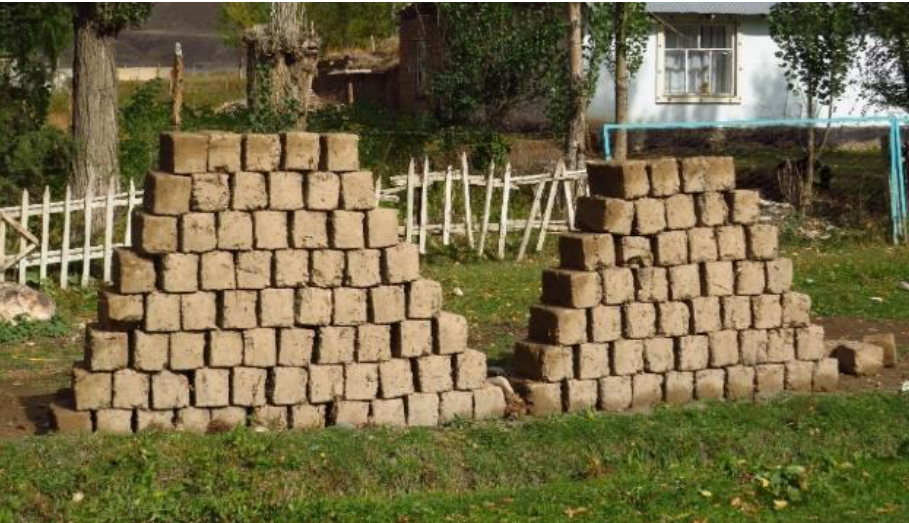
Figure 11. Clay-straw bricks being dried